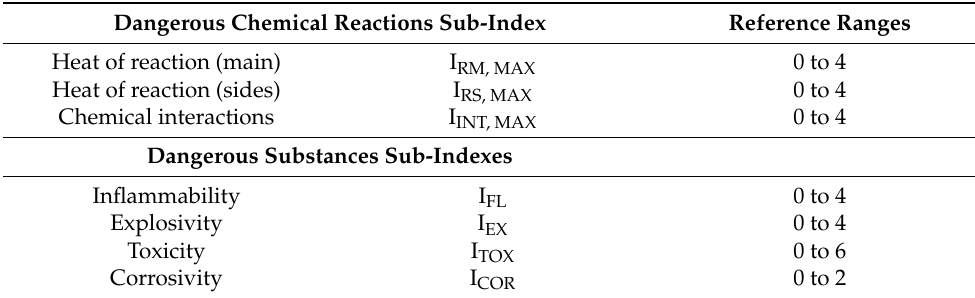
Table 1. Sub-indexes for calculating Chemical Safety Index (CSI).